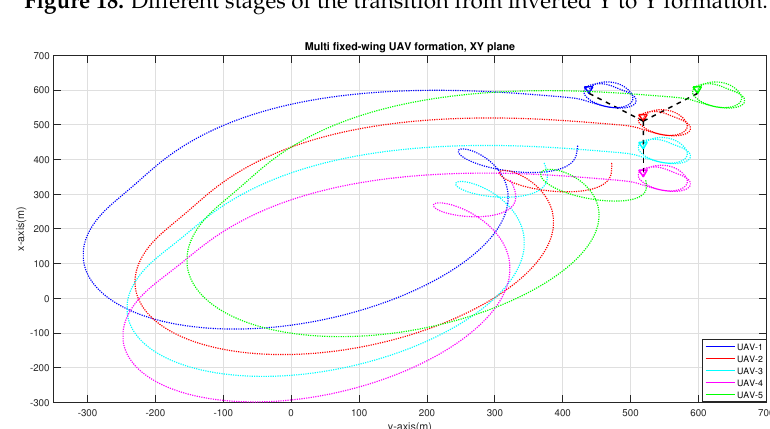
Figure 18. Different stages of the transition from inverted Y to Y formation.